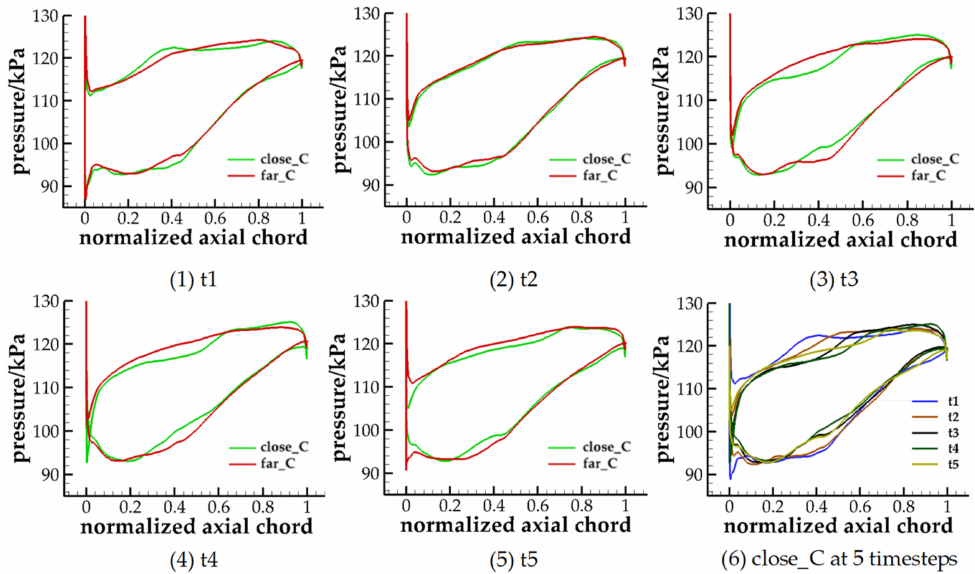
Figure 16. Transient pressure distribution of the 0.05 span at C